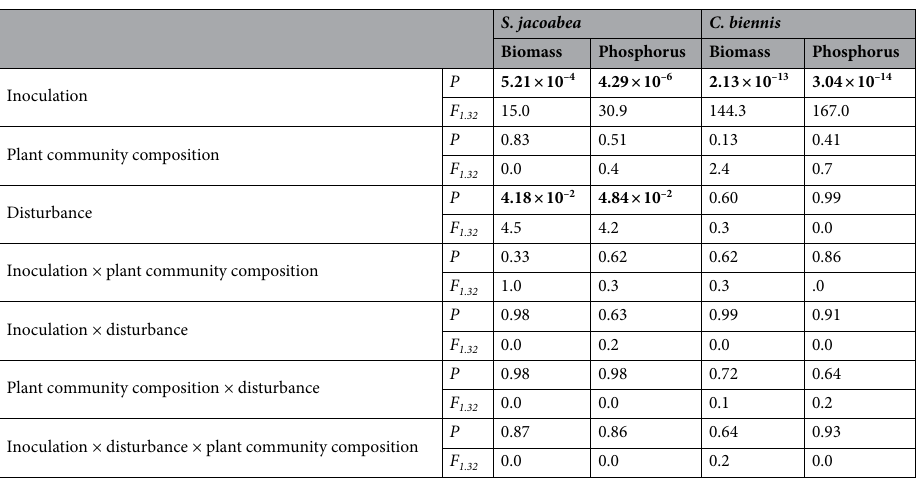
Table 2. Significance of effects of mycorrhizal inoculation, plant community composition (monocrop or multicrop) and disturbance, and their interaction on shoot dry biomass and shoot phosphorus content of perennial plants Senecio jacobaea and Crepis biennis. F ‐ values (F) and levels of statistical significance ( p -value ranges, P ) as per three-way ANOVAs are shown (n = 5). Significant results are stated in